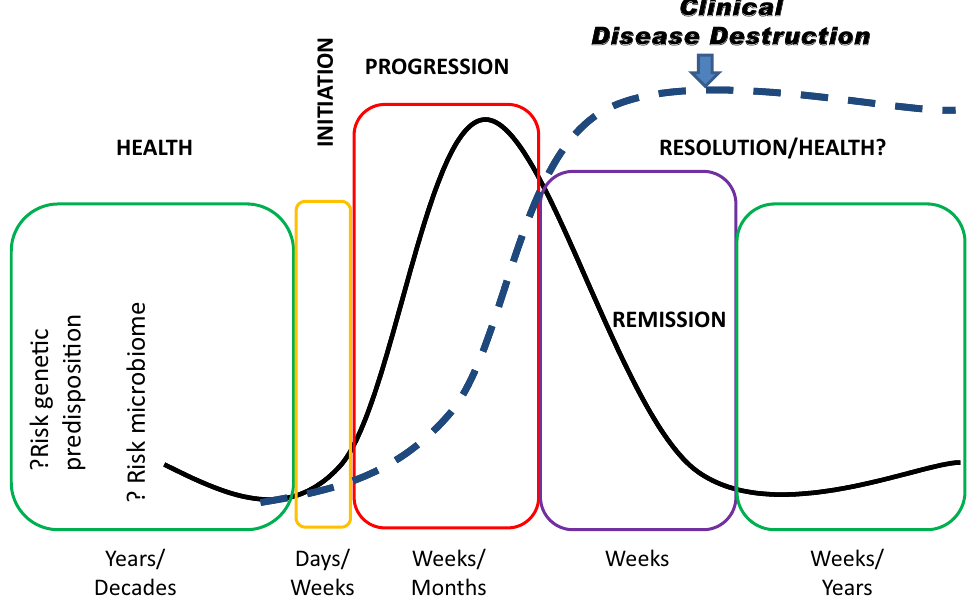
Figure 1. Model of exacerbations and remission of periodontal disease lesions. Graph reflects inherent risk due to genetic predisposition and existing oral microbiome characteristics. Biologic changes occur with initiation and progression of disease the generally presage the clinical changes measured. The model indicates that the biological parameters of disease stabilize and decrease during disease remission and resolution. However, the clinical features of lost epithelial attachment, connective tissue destruction and alveolar bone resorption remain as markers of the previous disease